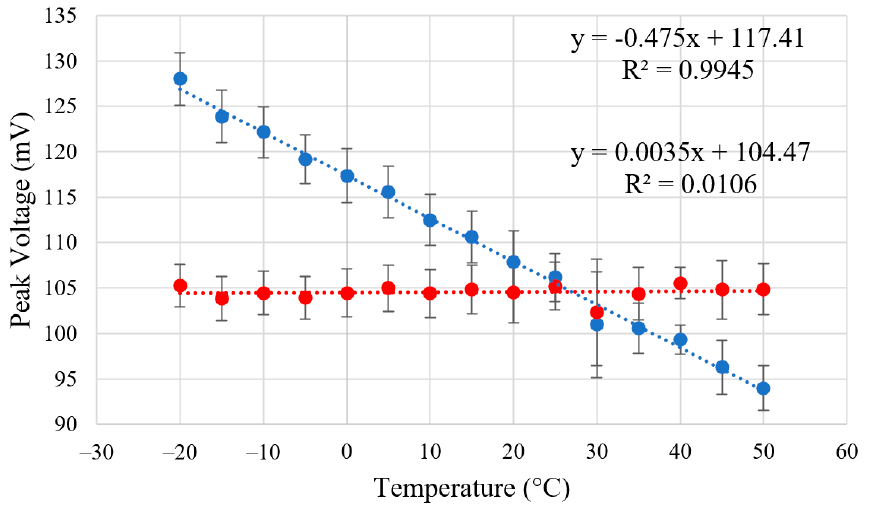
Figure 6. LTspice simulation plotting the peak to peak magnitude of each simulated pulse against temperature ◦ C. Blue and red points correspond to the non-compensated and Zener compensated system, respectively, both fitted with a linear dotted line. Three sigma error bars have been added based on the results of 10 simulations.